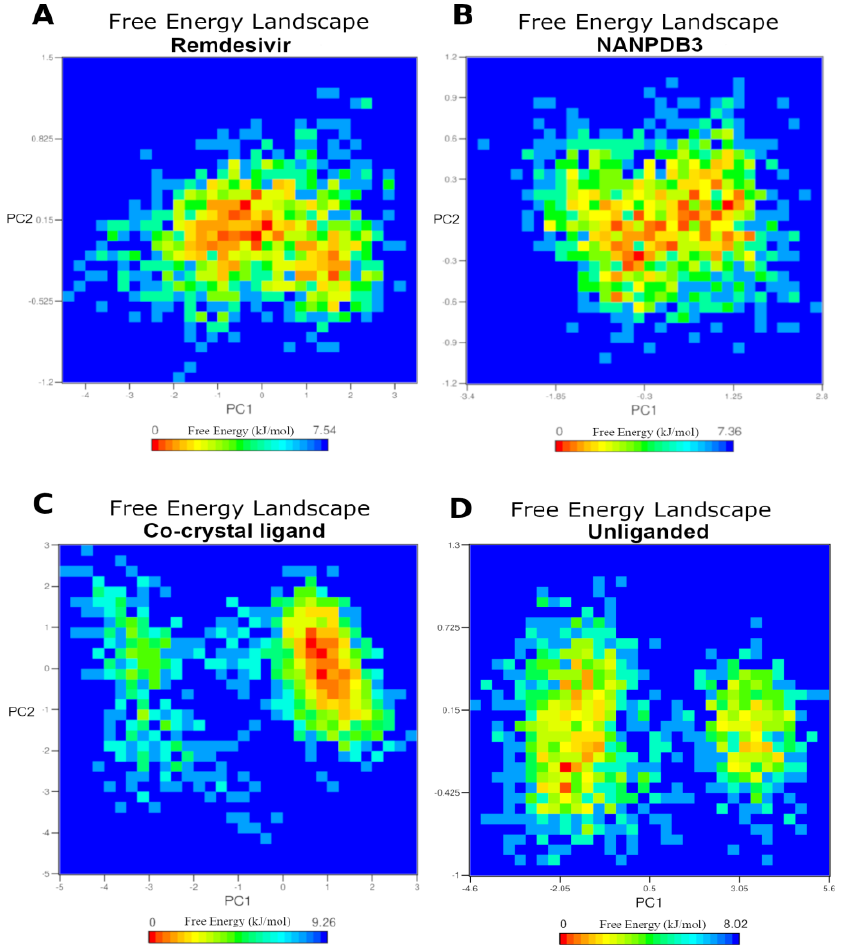
Figure 9. The free energy landscape (FEL) of the simulated Fascin systems based on the principal component analysis. ( A ) Remdesivir − Fascin complex system. ( B ) NANPDB3 − Fascin complex system. ( C ) The co − crystal ligand − Fascin complex system. ( D ) The unliganded − Fascin system. The color bar represents the free energy value in kcal mol − 1 . The color ranges from red to yellow to blue spots indicate the energy minima and energetically favored protein conformations to more unfavorable high-energy conformations.